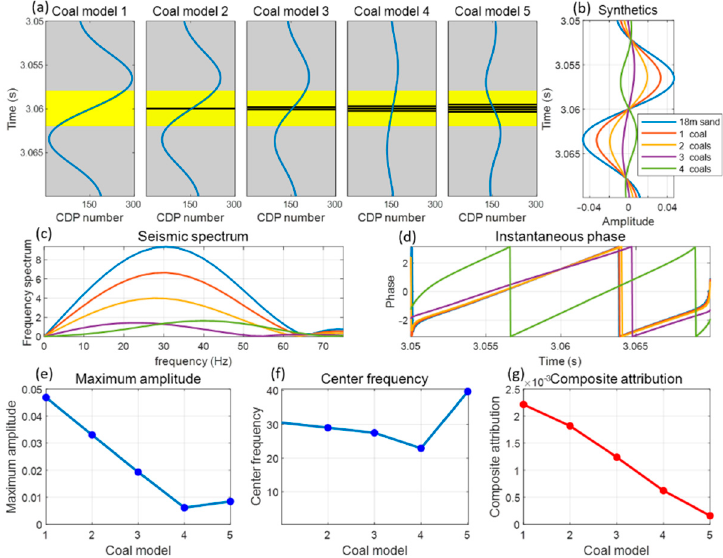
Figure 6. Model of thin coal seams coupled with sandstone and its synthetics and attributes: ( a ) coal model, ( b ) synthetic, ( c ) seismic frequency spectrum, ( d ) instantaneous phase, ( e ) maximum ampli- tude, ( f ) centre frequency, and ( g ) composite attribute.